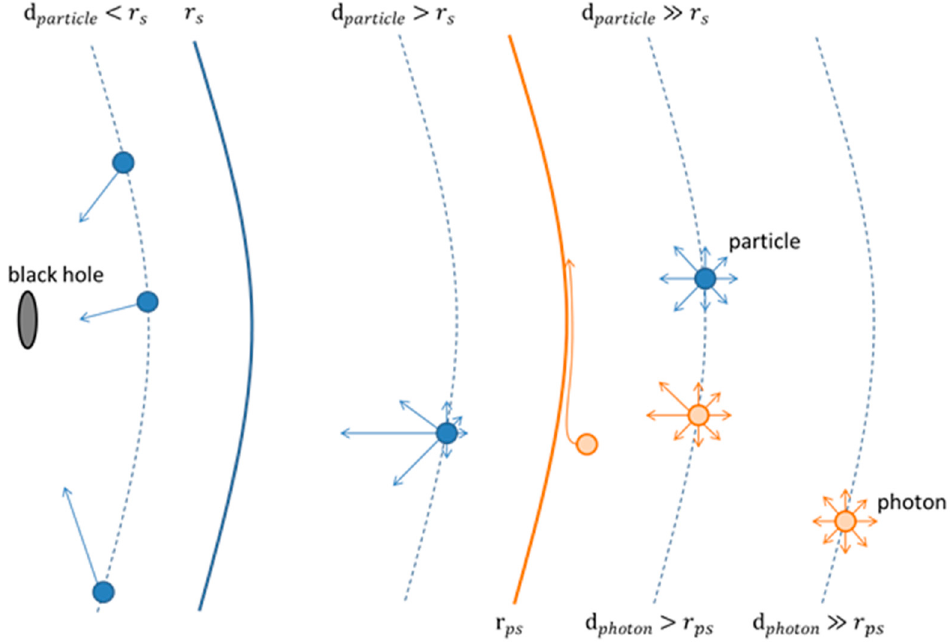
Figure 7. The moving behaviour of different particles depending on the distance between particle, event horizon, and photon sphere.